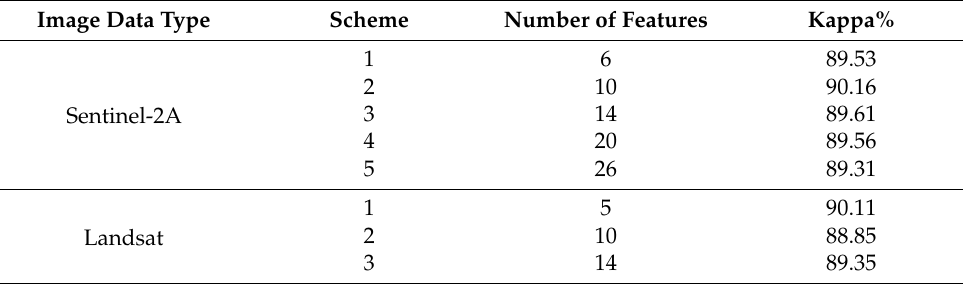
Table 4. Comparison of accuracy of different solutions for Sentinel